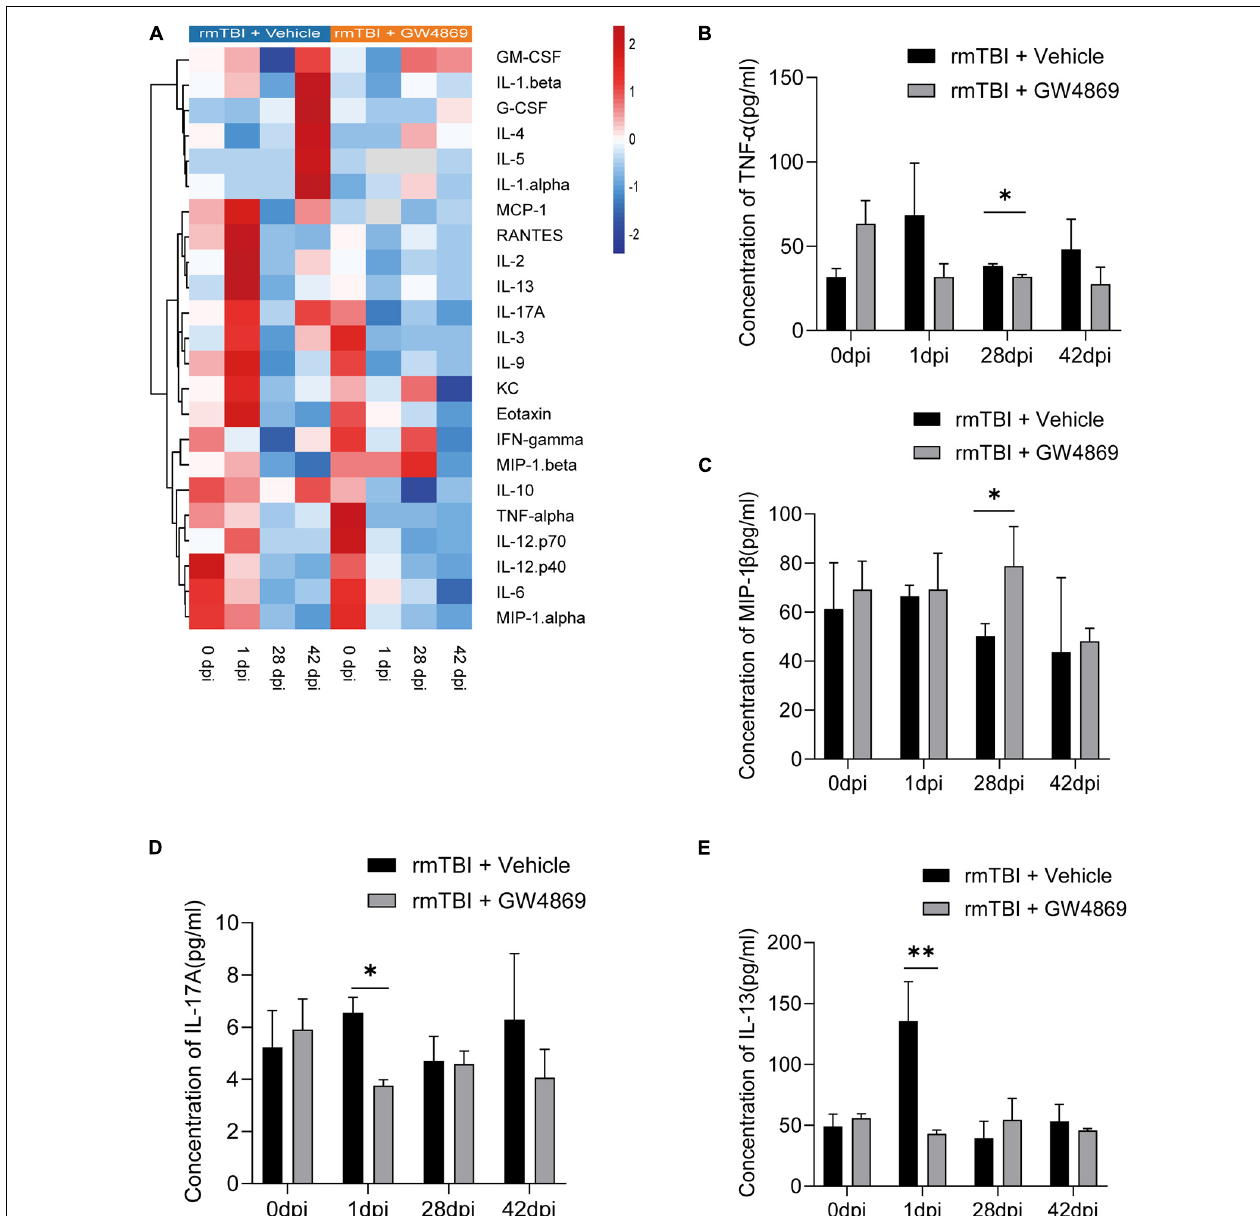
FIGURE 5 | (A) Heatmap showing the cytokine expression profiles in the brains of mice with rmTBI treated with GW4869 or Vehicle control at 0, 1, 28, and 42 dpi after rmTBI. (B–E) Bar graphs showing different trends of cytokine expression in the of rmTBI + GW4869 group versus the rmTBI + Vehicle group. (B) Bar graph showing that the concentration of TNF- α decreased at 28 dpi after GW4869 treatment. (C) Bar graph showing that the concentration of MIP-1 β increased at 28dpi after GW4869 treatment. (D) Bar graph showing that the concentration of IL-17A increased at 1dpi after GW4869 treatment. (E) Bar graph showing that the concentration of IL-13 decreased at 1dpi after GW4869 treatment. Mean ± SD. n = 3 mice per group. ∗ p < 0.05, ∗∗ p <